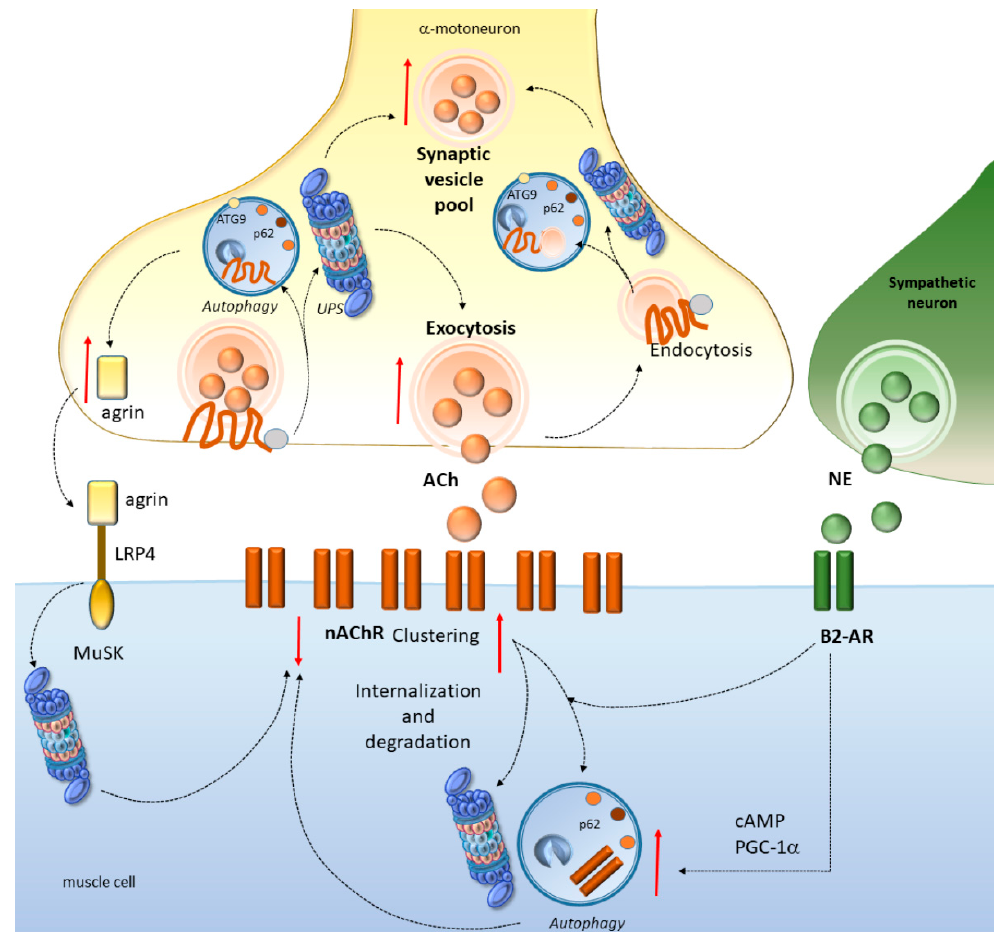
Figure 4. Autophagy and the UPS at the neuromuscular junction. Autophagy and the UPS promote neurotransmitter (acetylcholine, ACh) release and contribute to rejuvenating the synaptic vesicle pool through the turnover of specific proteins that are implicated in synaptic vesicle exocytosis and endocytosis. Autophagy activity is also bound the to the production of agrin, which together with muscle-specific receptor tyrosine kinase (MuSK), a UPS substrate, forms a complex that is key to maintaining the neuromuscular junction (NMJ) and to regulating nAChR at the postsynapse. Here, autophagy and the UPS are key to promote the internalization and degradation of AChR, which is also bound to the activity of adrenergic beta2 receptors (B2-ARs). In fact, B2-ARs contribute to regulating nAChR clustering and NMJ functions, likely through stimulation of autophagy via cAMP-peroxisome proliferator-activated receptor γ -coactivator 1 α (PGC-1 α) .